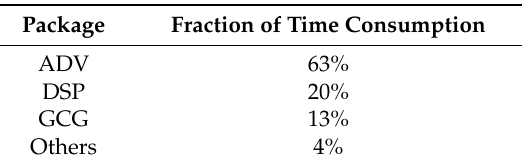
Table 1. Time consumption for different packages of